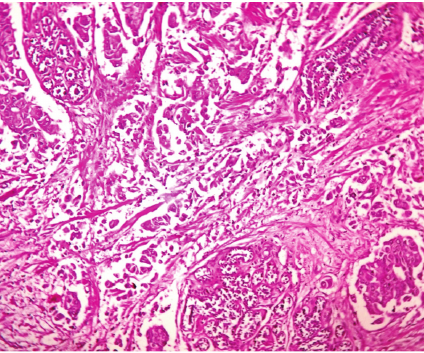
Figure 1: Photomicrograph showing tumor along with foci of adenosis showing apocrine metaplasia (H&E: 10x).